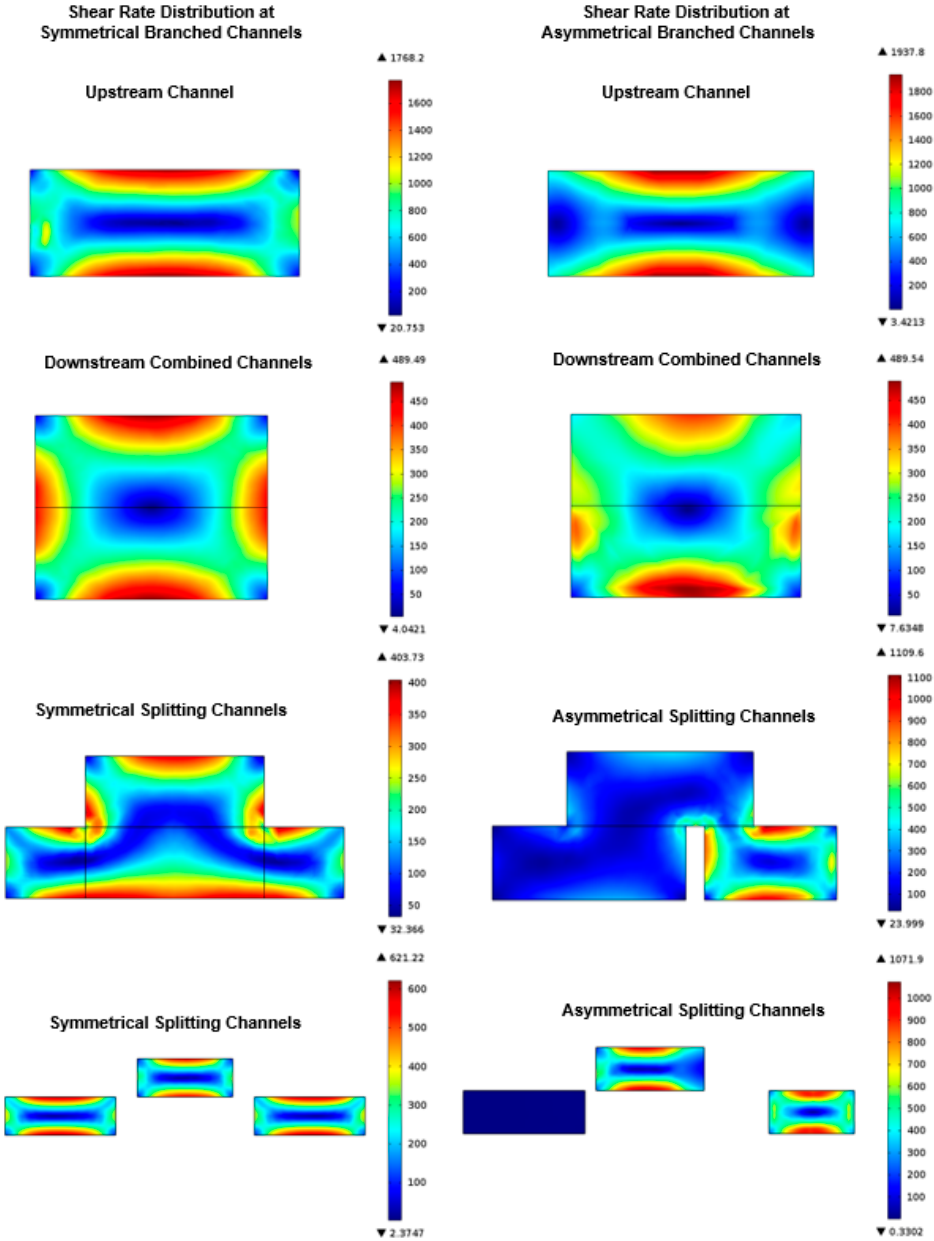
Figure 8. The simulated profile of shear rate distribution along the direction of the continuous phase flow at the top layer of extended T-junction (for system: Q c = 2 mL / h). The numbers indicate locations at which image profiles were taken.